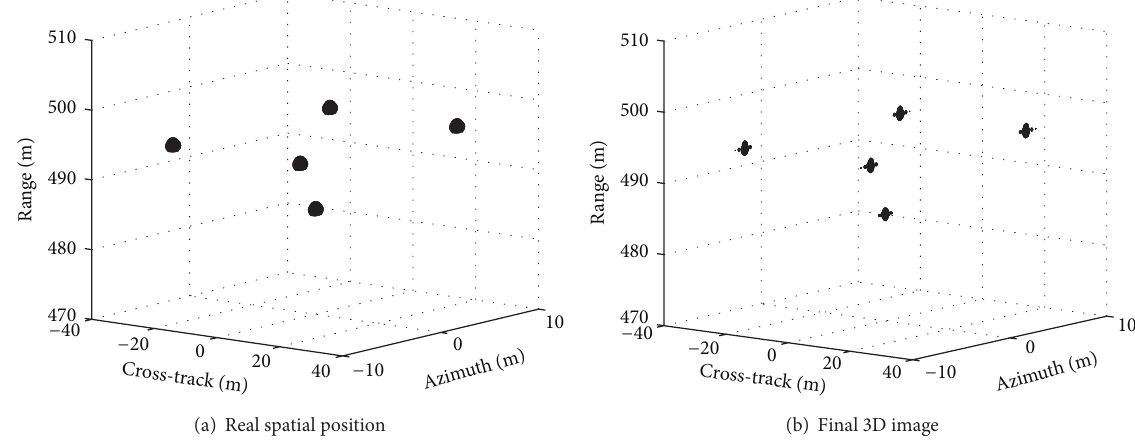
Figure 4: Real spatial position and final 3D image.